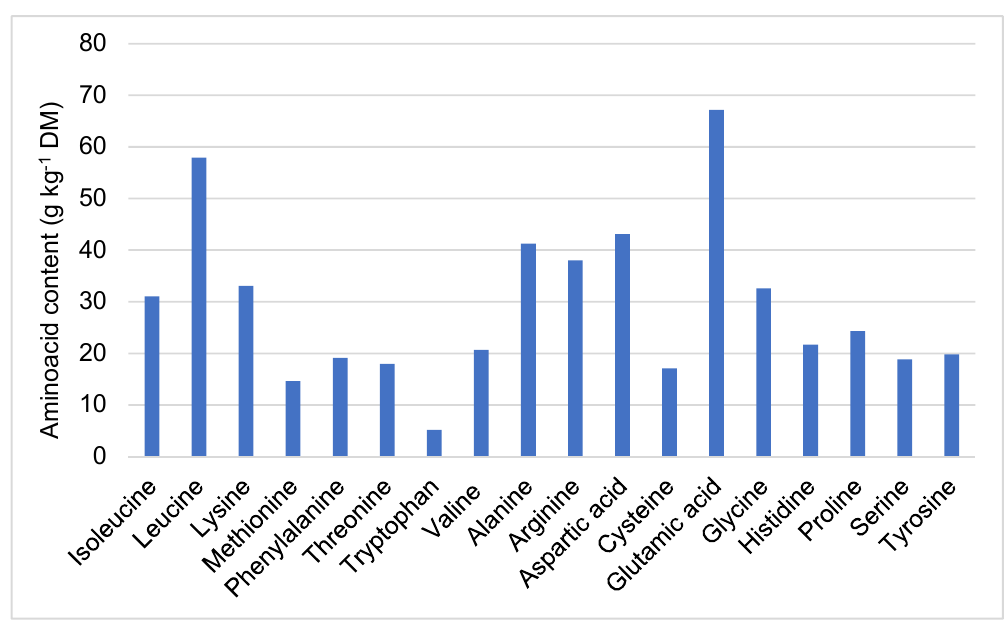
Figure 3. Content of essential and non ‐ essential amino acid in mealworm larvae (g kg − 1 DM). Source: [34] and [118].